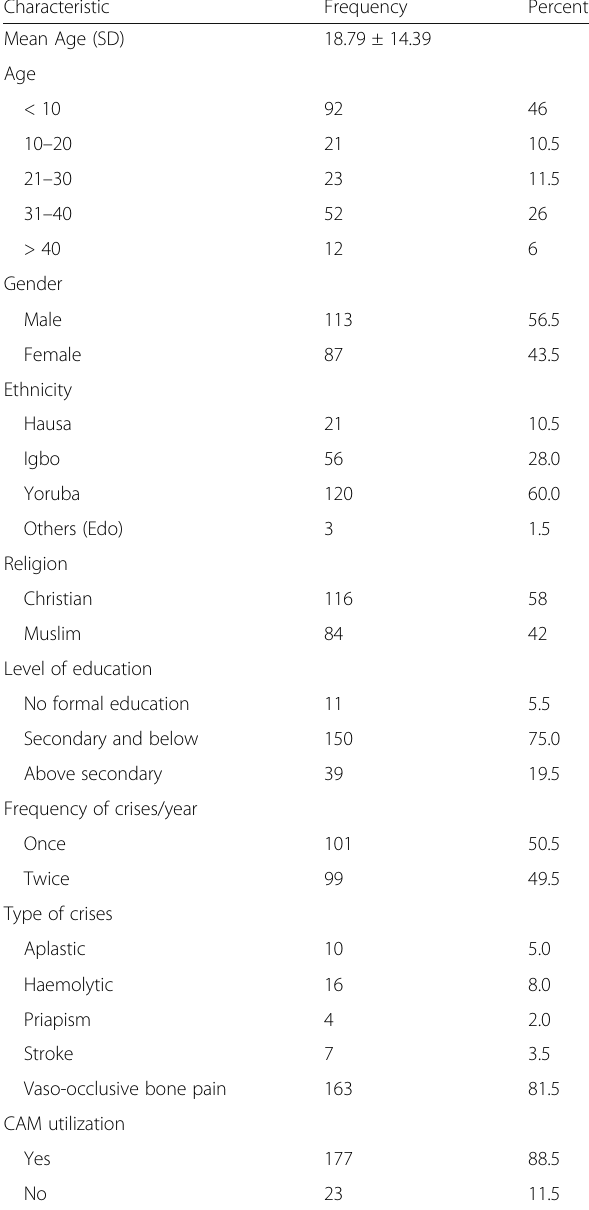
Table 1 Socio-demographic characteristic and frequency